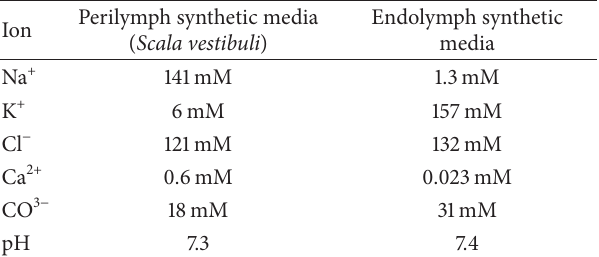
Table 2: Chemical composition of the synthetic cochlear fluids without protein (data summary adapted from Wangemann and Schacht)